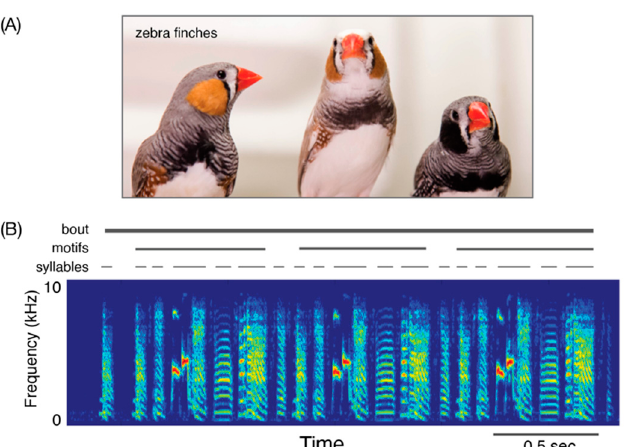
Figure 1. Songbirds and the building blocks of their songs. ( A ) Picture of three adult male zebra finches. Zebra finches are the most extensively studied songbird with regard to vocal learning; photo credit: Raina Fan. ( B ) Spectrogram (frequency on the y-axis, time on the x-axis, amplitude as differences in color) of a bout of zebra finch song. A “bout” of zebra finch song consists of the repetition of a “motif,” that itself consists of a stereotyped sequence of acoustic elements called “syllables.” Individual syllables and the epochs of silence between them range from tens to hundreds of milliseconds in duration with substantial variation across individuals and across species.